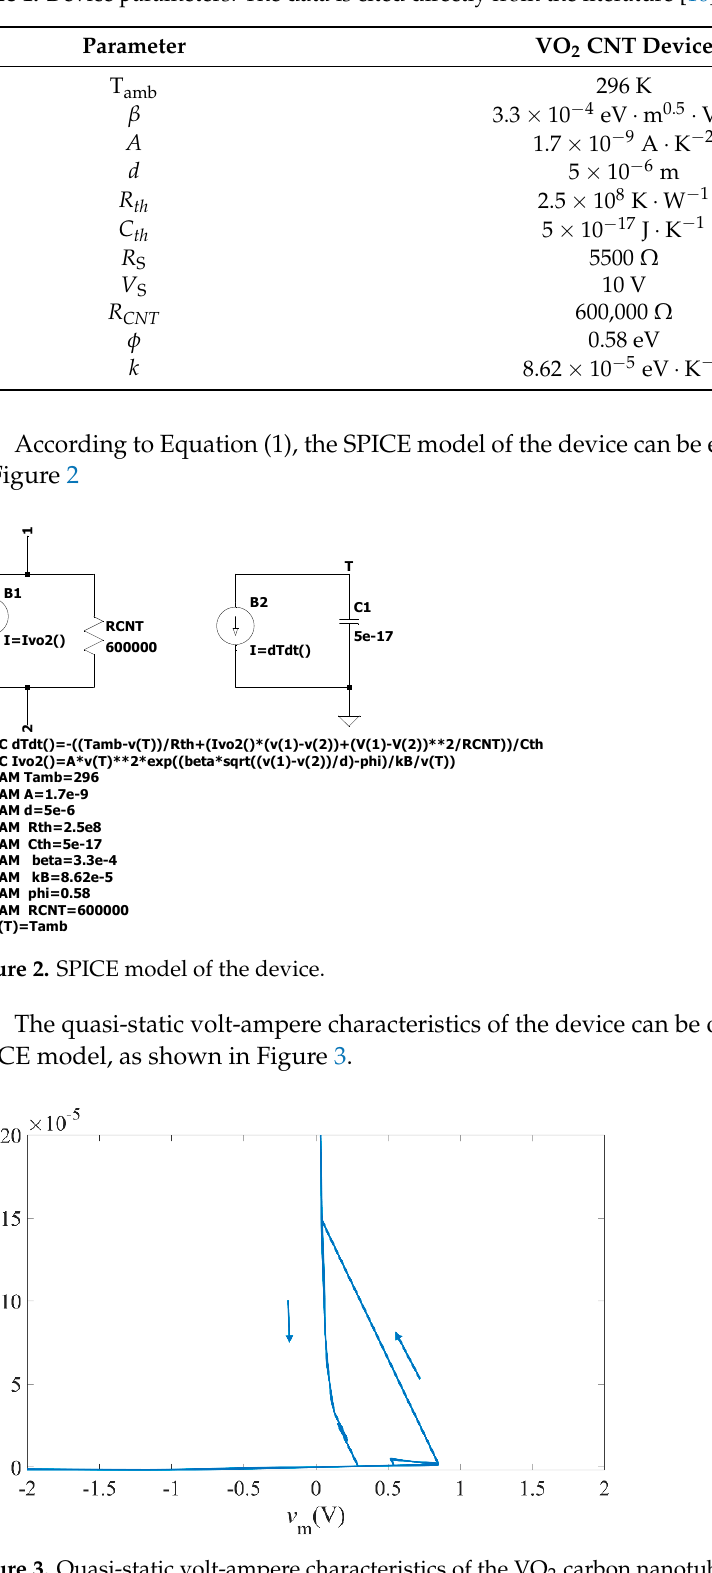
Figure 3. Quasi-static volt-ampere characteristics of the VO 2 carbon nanotube composite device.